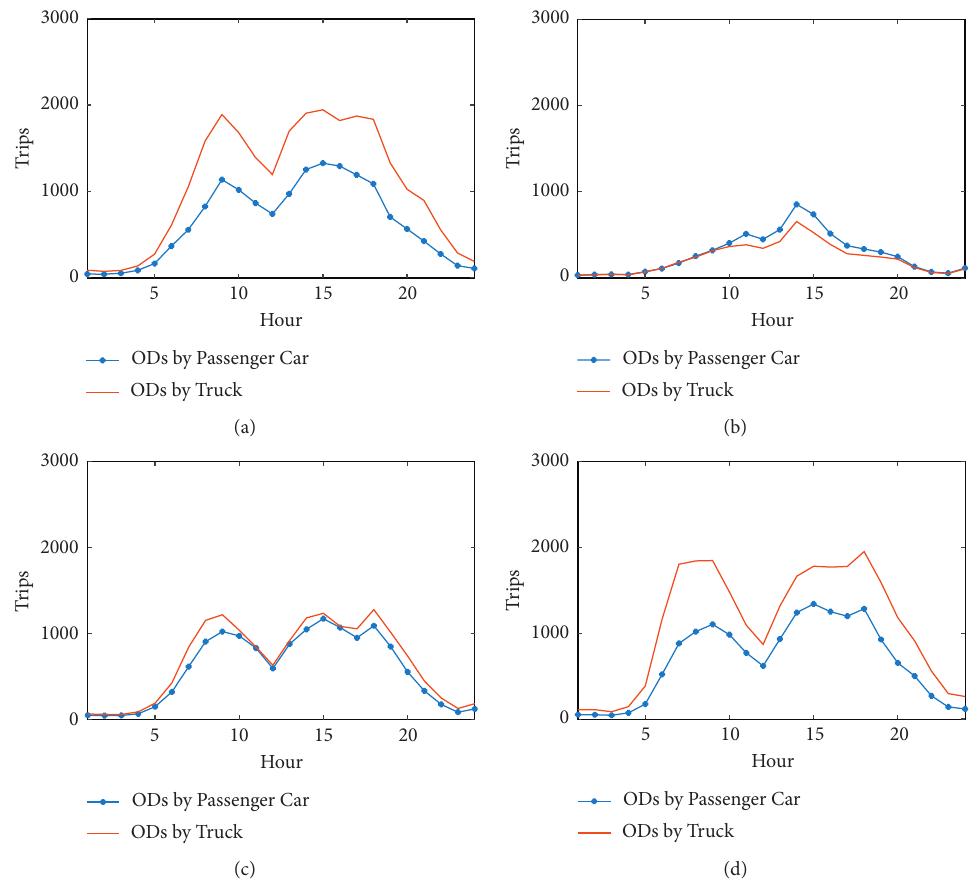
Figure 7: Hourly average numbers of the OD flows for Hefei-Lu’an using different types of vehicles in the four time periods. (a) before the outbreak, (b) during the outbreak, (c) after the return to work and production and (d) after Wuhan was